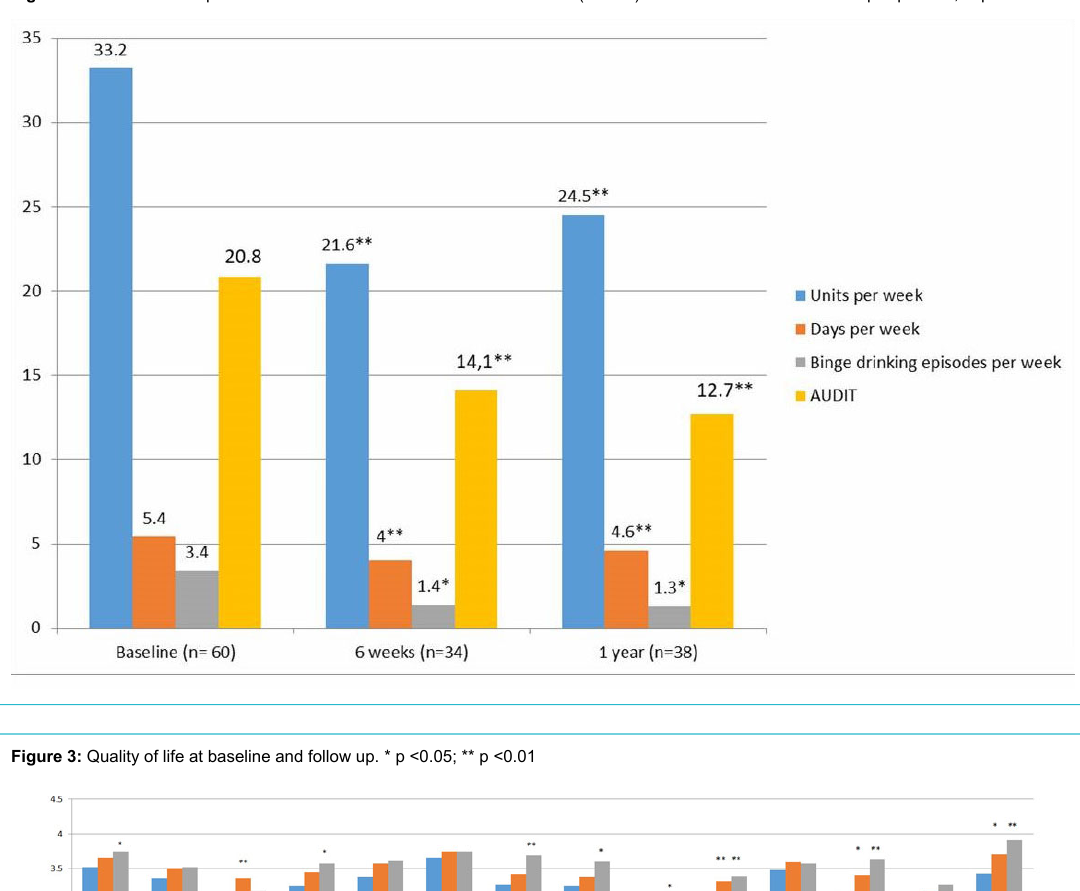
Figure 2: Alcohol consumption and Alcohol Use Disorder Identification Test (AUDIT) score at baseline and follow up. * p <0.05; ** p <0.01